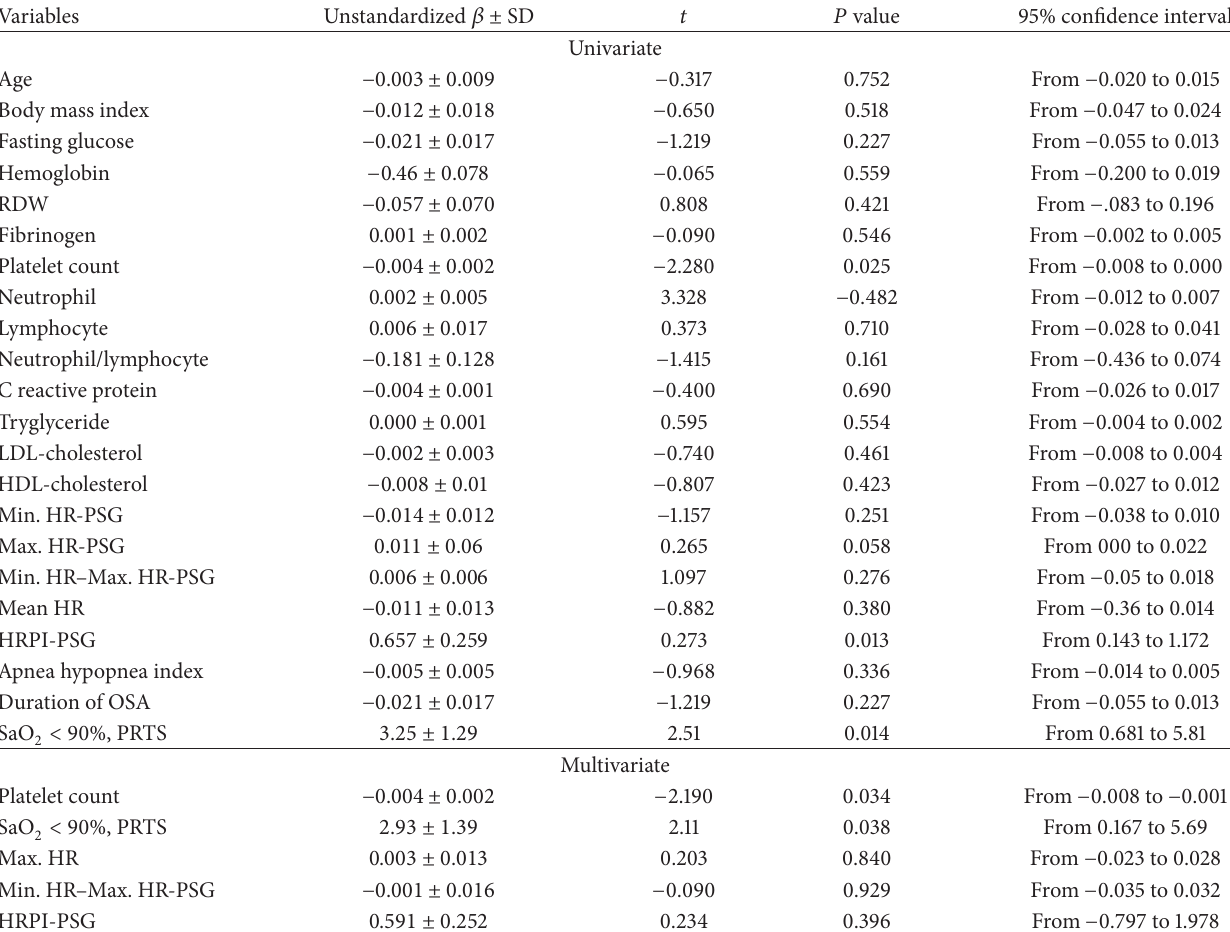
Table 4: Independent predictors of mean platelet volume in univariate and multivariate linear regression analysis in OSA